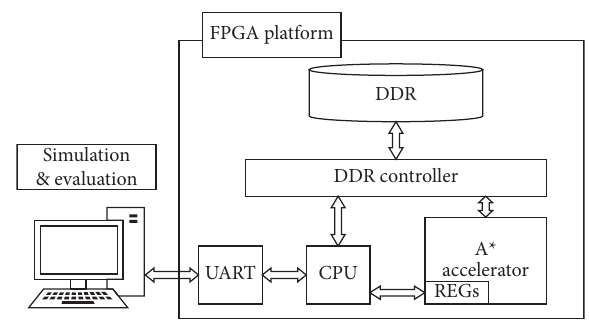
Figure 9: Diagram of the experimental platform.